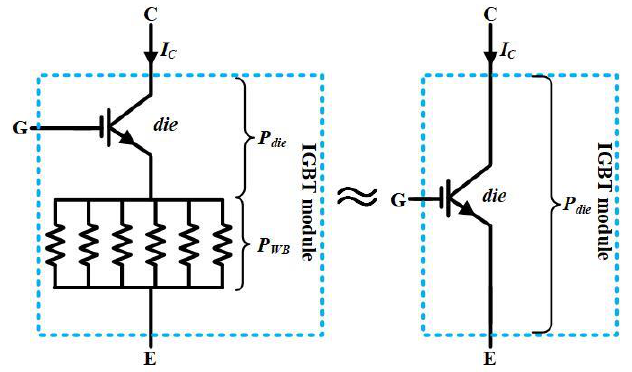
Figure 2. Power dissipation of IGBT module.